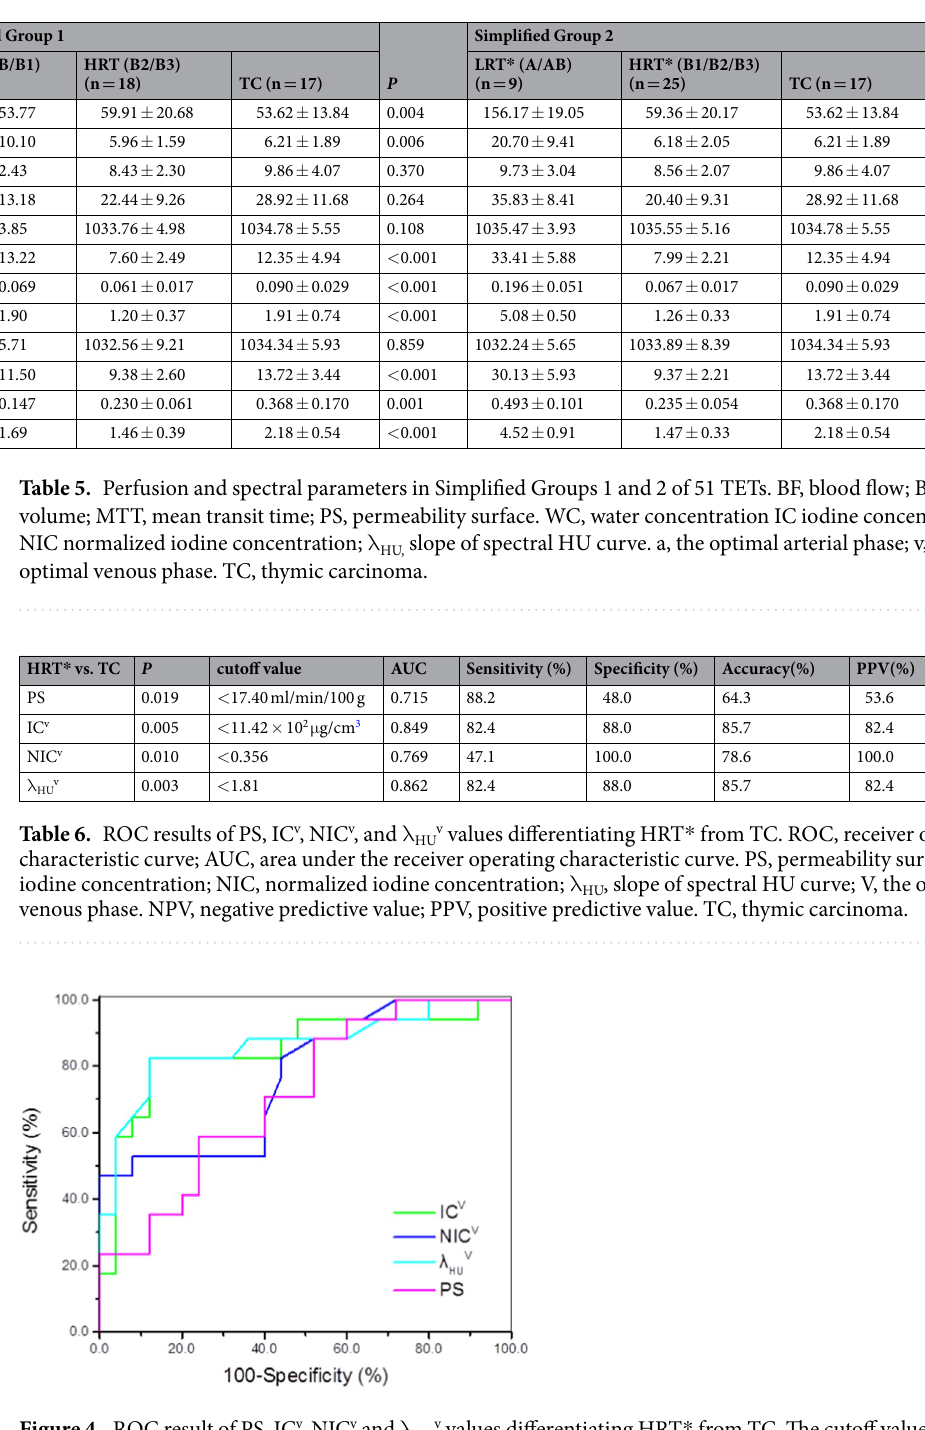
Figure 4. ROC result of PS, IC v , NIC v and λ HUv values differentiating HRT * from TC. The cutoff values of PS, IC v , NIC v , and λ HUv values used for differentiating HRT * from TC were 17.40 mL/min/100 g, 11.42 × 10 2 μ g/cm 3 , 0.356, and 1.81, respectively, with AUC of 0.715,0.849, 0.769, and 0.862, respectively, sensitivity of 88.2%, 82.4%, 47.1%, and 82.4%, respectively, and specificity of 48.0%, 88.0%, 100.0%, and 88.0%, respectively, accuracy of 64.3%, 85.7%, 78.6%, 85.7%, respectively, PPV of 53.6%, 82.4%, 100.0%, 82.4%, respectively, NPV of 92.9%, 95.7%, 73.5%, 95.7%, respectively.